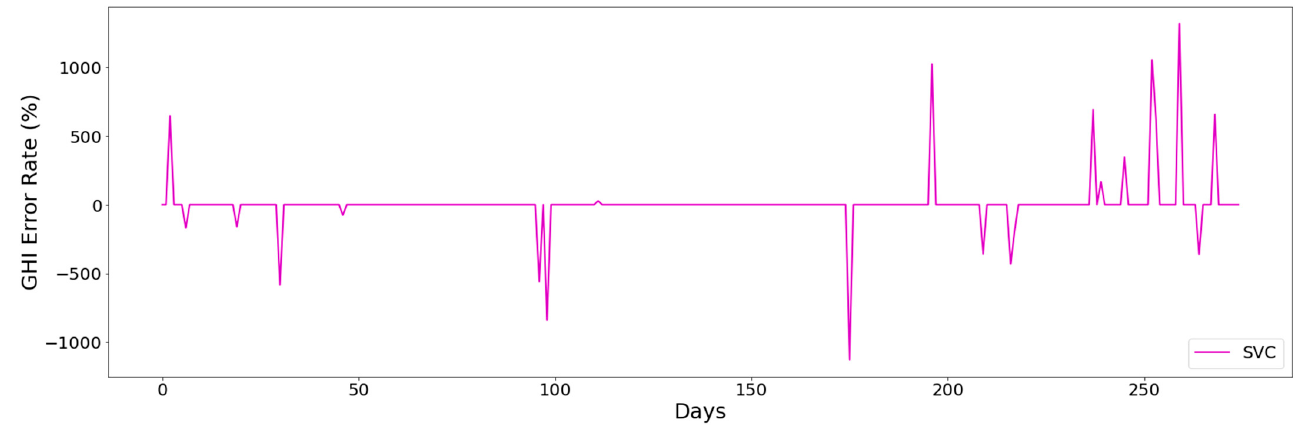
Figure 16. SVC error frequency rate.